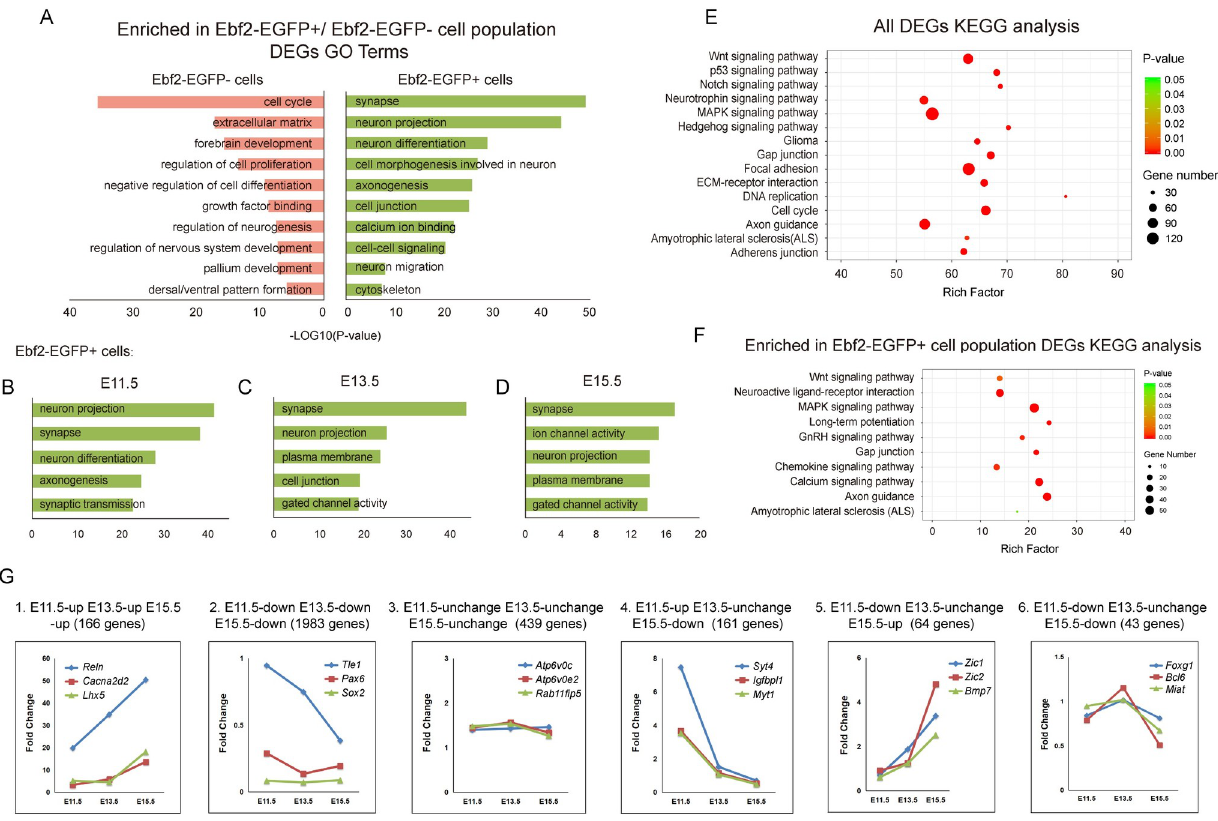
Fig 2. Temporal dynamic DEGs in Ebf2-EGFP+ cells and Ebf2-EGFP- cells show early neuron differentiation progression. (A) Enriched functional assessments (including biological processes, cellular components and molecular function) of highly expressed DEGs (fold change � 2) in Ebf2-EGFP+ or Ebf2-EGFP- cell population. (B-D) Enriched functional assessments of highly expressed DEGs in Ebf2-EGFP+ cell population at E11.5, E13.5 or E15.5, respectively. (E-F) Significantly (p < 0.001, FDR < 0.001) enriched KEGG pathways within DEGs from all RNA-seq samples and DEGs enriched in Ebf2-EGFP+ samples, respectively. (G) Temporal dynamic expression patterns of DEGs across the three different early neurogenic stages (y axis = Fold Change between Ebf2-EGFP+ cells and Ebf2-EGFP- cells). Noted the dynamic pattern is related to functions of associated genes.